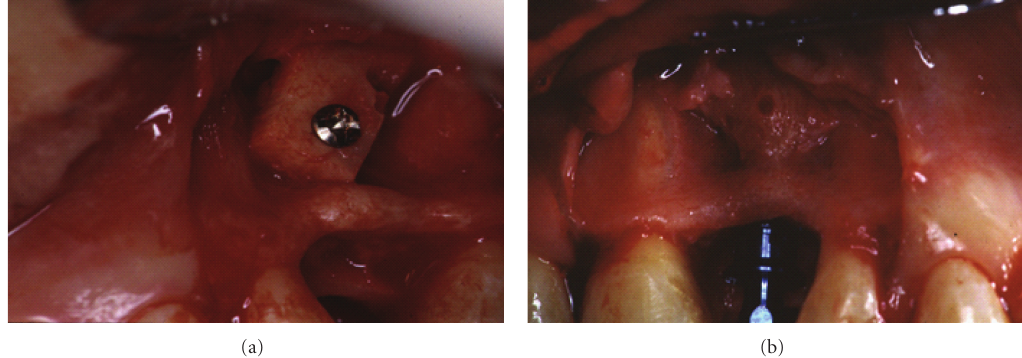
Figure 2: Intraoral view of autogenous block graft taken from the mandibular symphysis, at time of fixation in no. 24 site (a). Intraoral view of placement of implant in no. 24 site after successful graft, at time of removal of fixation screw